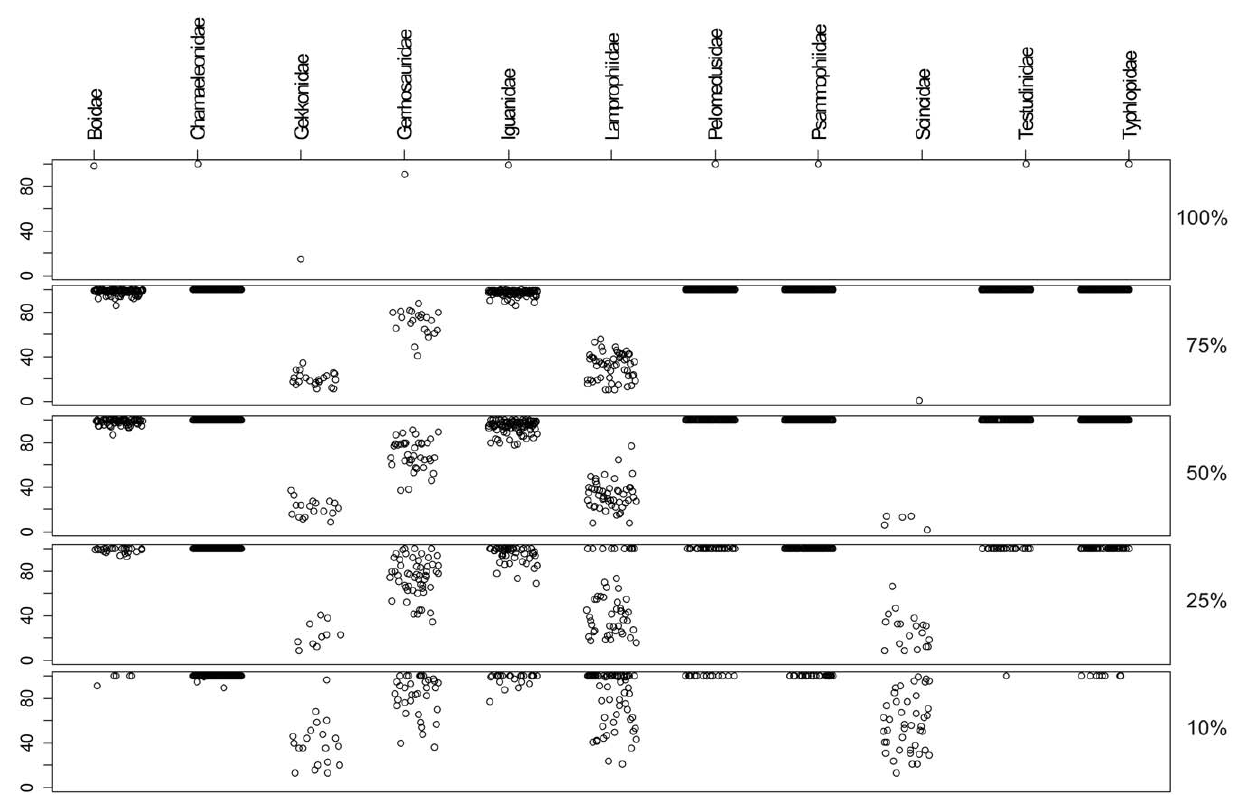
Figure 3. Plot of bootstrap values supporting monophyly of families with different taxon sampling density. Values were obtained by neighbor-joining analyses including 100% (original data set), 75, 50, 25 and 10% (100 random subsets each) of the studied species, respectively. Support values for taxa recovered as non-monophyletic groups are not shown.